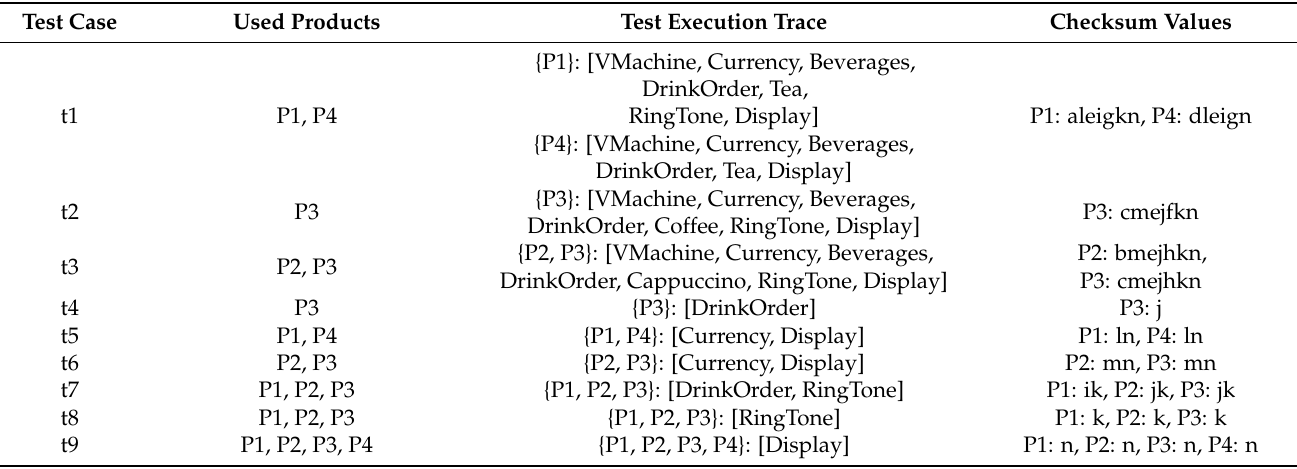
Table 5. Execution traces of test cases and their checksum values for SPL V0